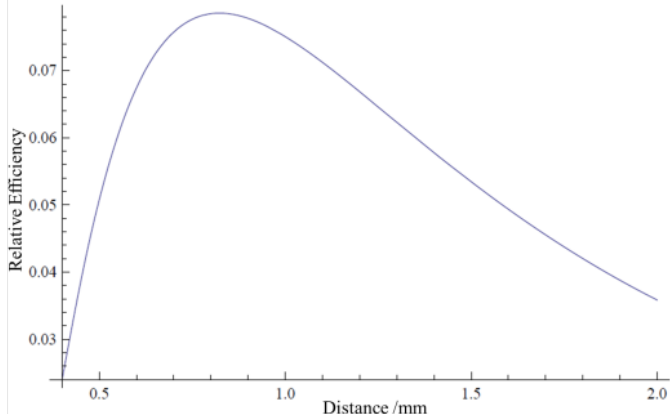
Figure 6. Relative detecting efficiency of different fiber center distances.